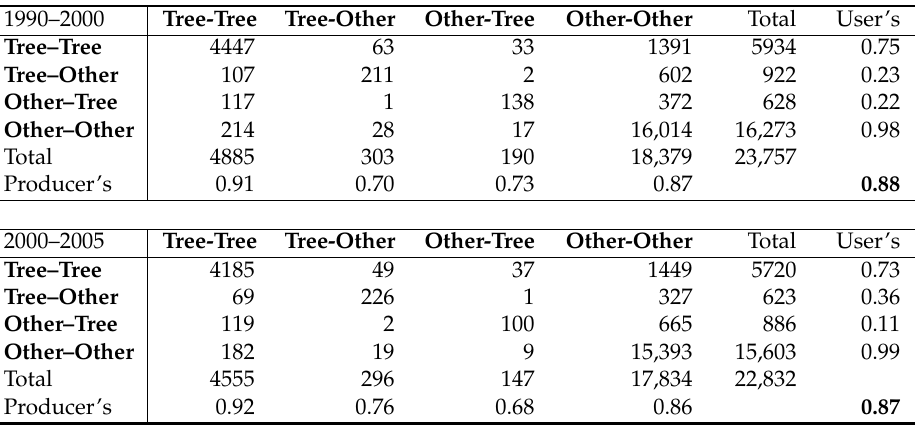
Table 4. Confusion matrix for change classes for the time periods 1990–2000 (top) and 2000–2005 (bottom) before and after expert review and revision. Figures are based on area in each class (thousands of hectares). Automatically mapped class labels are on left-hand side and the expert reviewed and revised labels are across the top of the table. Tree-Tree = Tree cover in both periods, Tree-Other = Tree cover change to other land, Other-Tree = other land to tree cover, Other-Other = other land cover in both